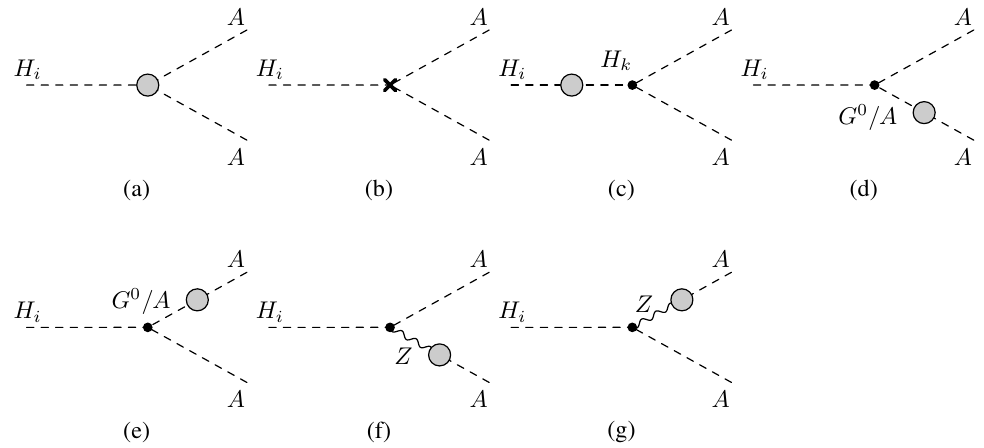
Figure 7 . Generic diagrams contributing to the virtual corrections of the decay H i ! AA : vertex corrections (a) and corrections to the external legs (c)-(g). Diagram (b) displays the corresponding vertex counterterm.